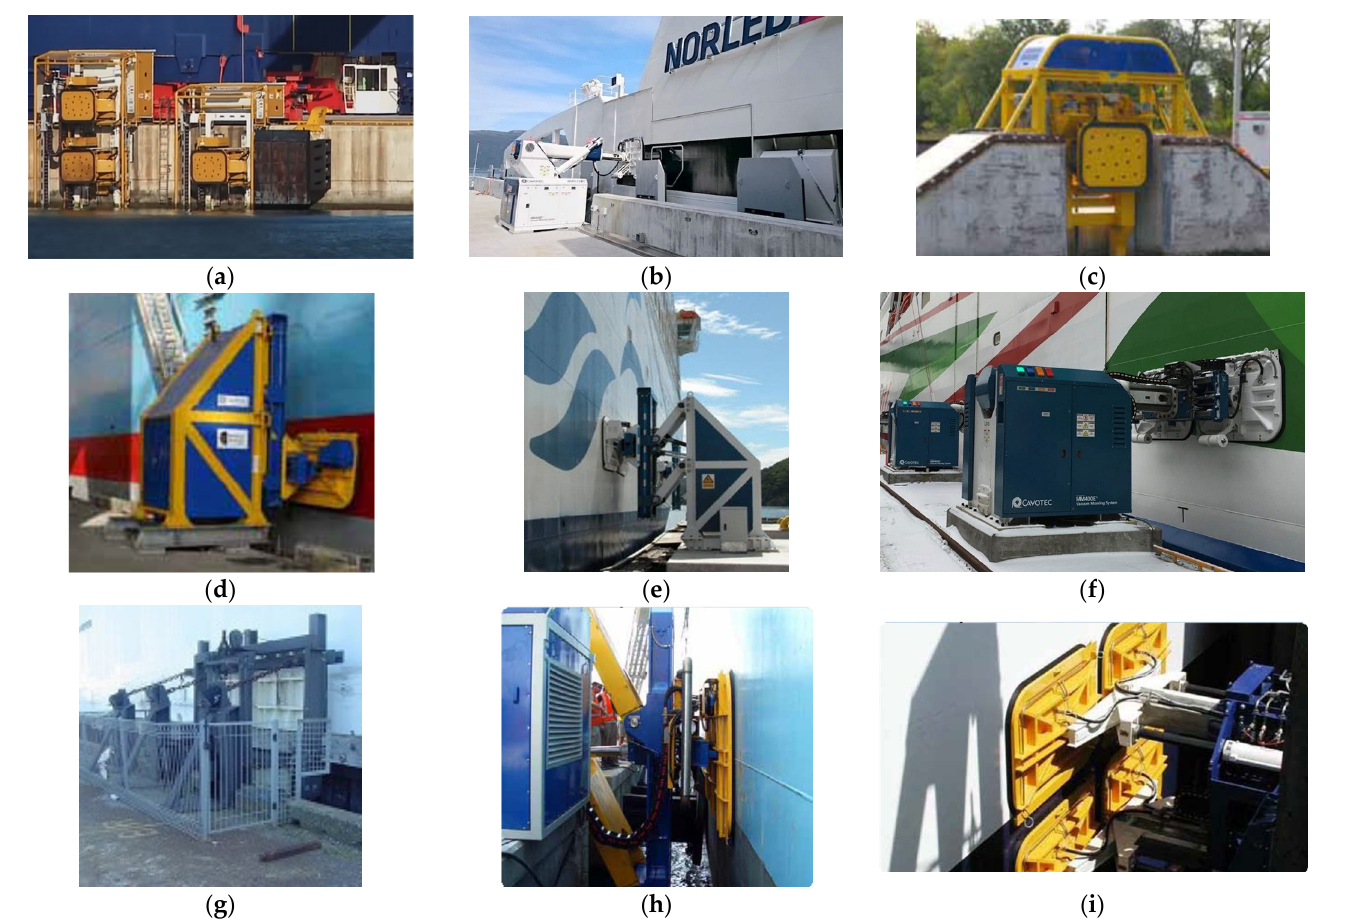
Figure 5. MoorMaster TM vacuum mooring systems type showing ( a ) MM200C, ( b ) MM200E, ( c ) MM200LS, ( d ) MM400, ( e ) MM400A, ( f ) MM400E, ( g ) MM I-400, ( h ) MM600, ( i ) MM800 (adapted with permission from Ref. [28]. 2014. Cavotec).